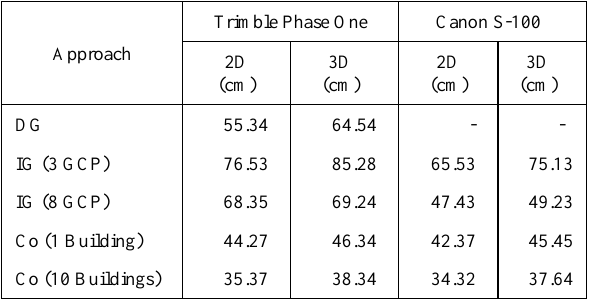
Table 4. ICP Level 2 (DG:Direct Georeferencing, IG:Indirect Georeferencing, Co:Combined DG-IG)